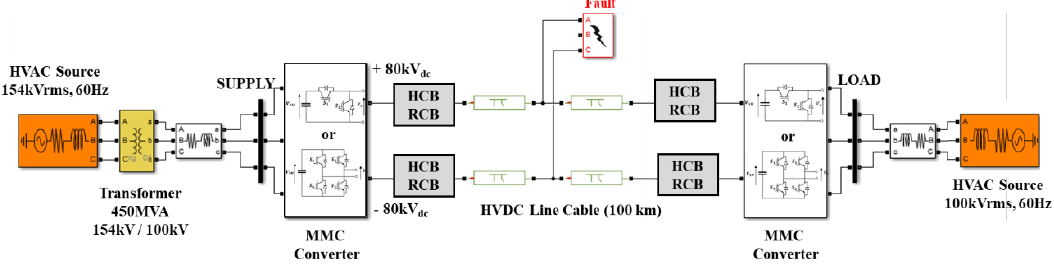
Figure 2. Test bed model in Matlab/Simulink. Converters are composed of 40-level HB- and FB-MMCs. The pole-to-pole DC fault is introduced at a variable distance from the rectifier. Table 1. Summary of high-voltage direct-voltage (HVDC) system parameters.